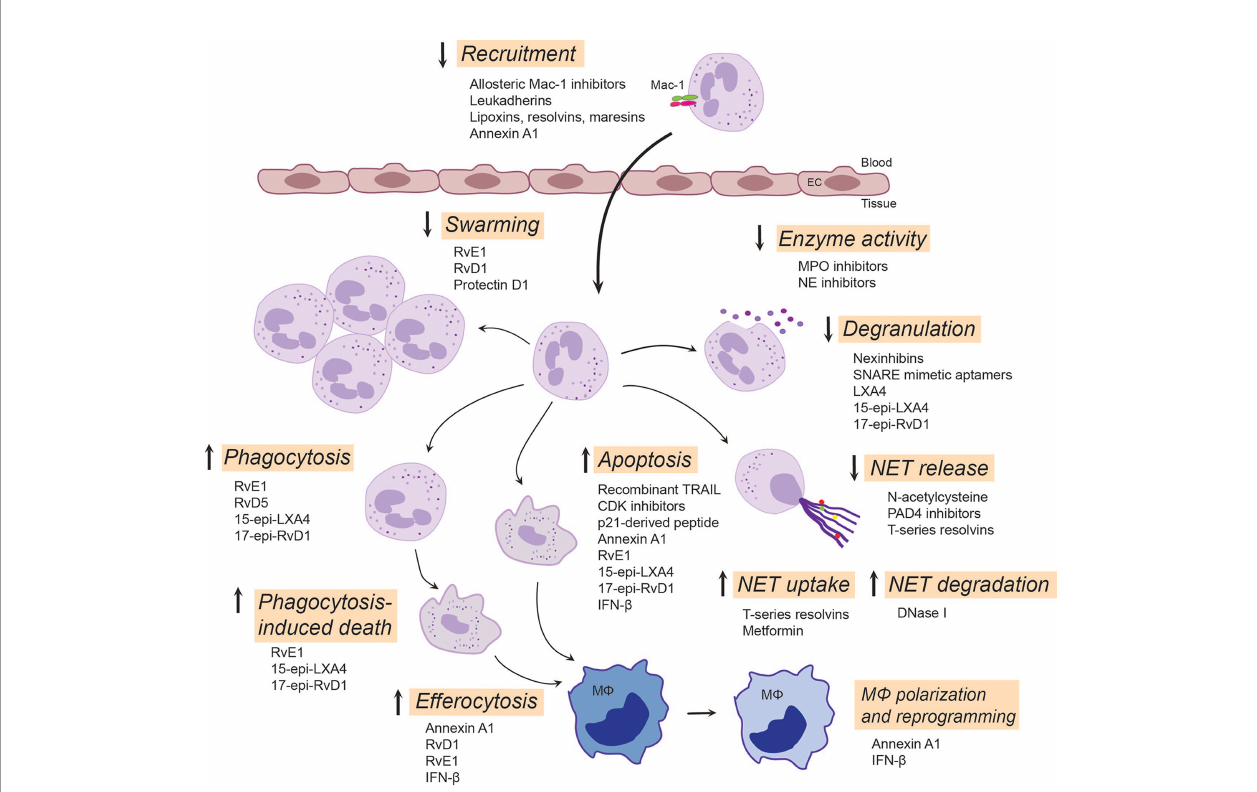
FIGURE 2 | Emerging neutrophil-targeted therapeutic approaches to promote the resolution of in fl ammation. The strategies include blocking, restoring or activating neutrophil functions. Thus, blocking function of Mac-1 or upregulation of Mac-1expression dampens neutrophil accumulation, a critical component of terminating the in fl ammatory response. LXA 4 , RvE3 and protectin D1 serve as stop signals for swarming. Inhibition of degranulation or the activity of secreted enzymes, such as MPO and NE, could reduce tissue injury and alter composition of NETs. Enhancing NET degradation by DNase I or promoting NET uptake by T-series resolvins or